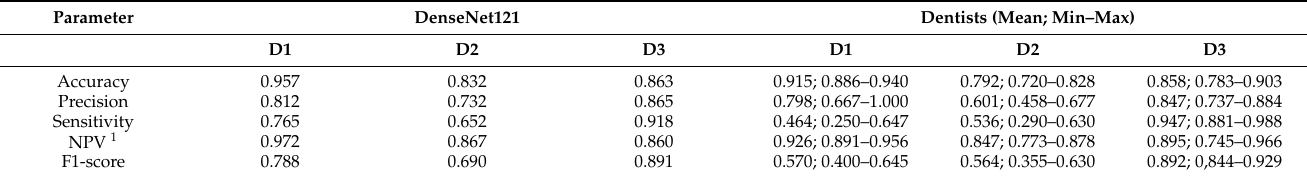
Table 4. Classification performances of DenseNet121 and the dentists with the test set.